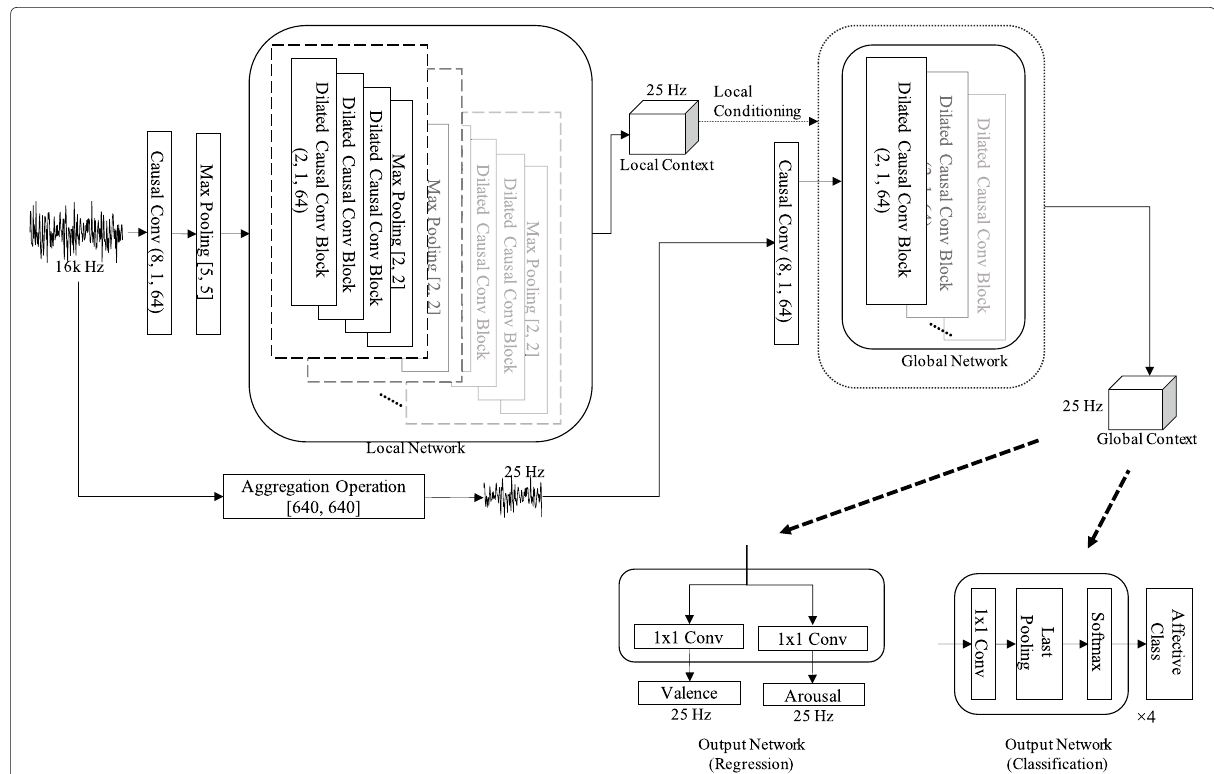
Fig. 1 The proposed end-to-end SER model denoted as the dilated-causal-convolution-only speech emotion recognition with context stacking (DiCCOSER-CS). The convolution filter width, stride and filter depth are listed in round brackets, and the pooling width and stride are listed in square